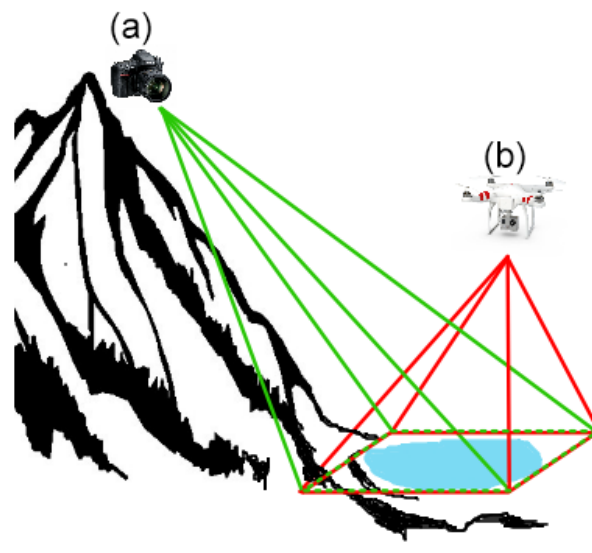
Figure 4. (a) Recording with the camera from an angle; (b) record- ing of actual state of alpine lake with the quadrocopter perpendicu- lar to the alpine